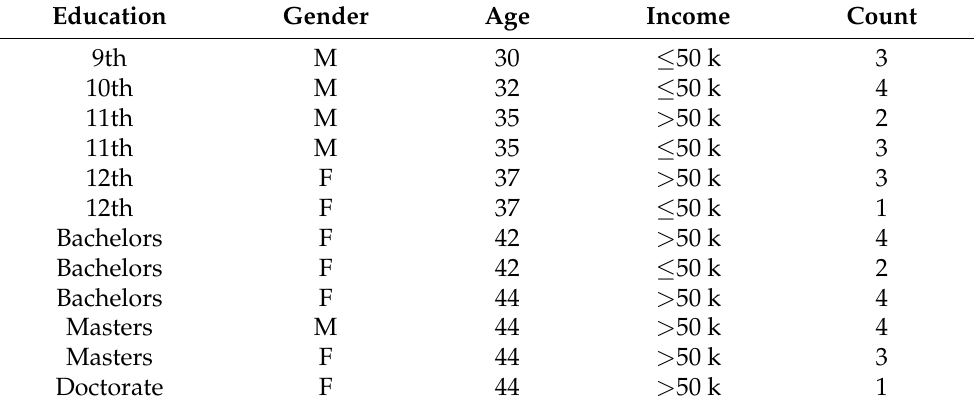
Table 2. A sample dataset.